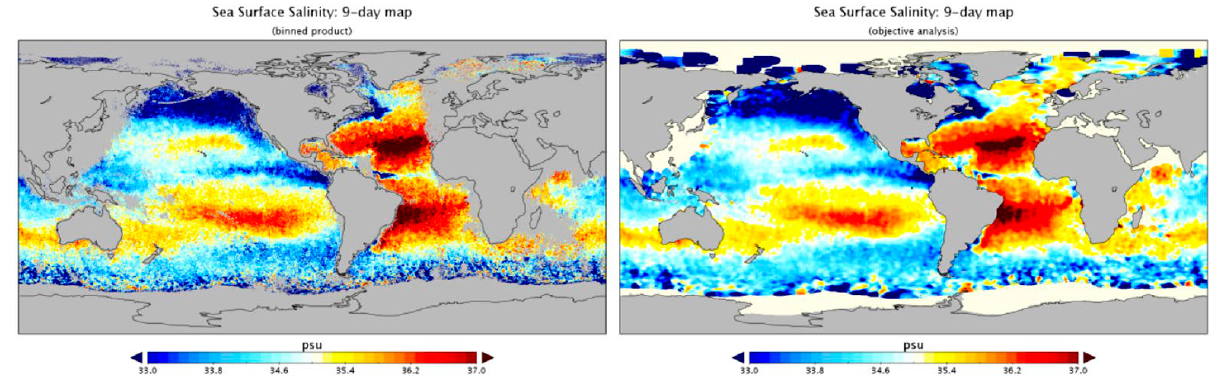
Fig. 7. – Sea Surface Salinity maps with spatial resolution of 0.25°×0.25° and temporal resolution of 9 days. Left, map computed by averaging the properly filtered L2 (Level 2) salinities. Right, objective analysis was used for the processing of the filtered